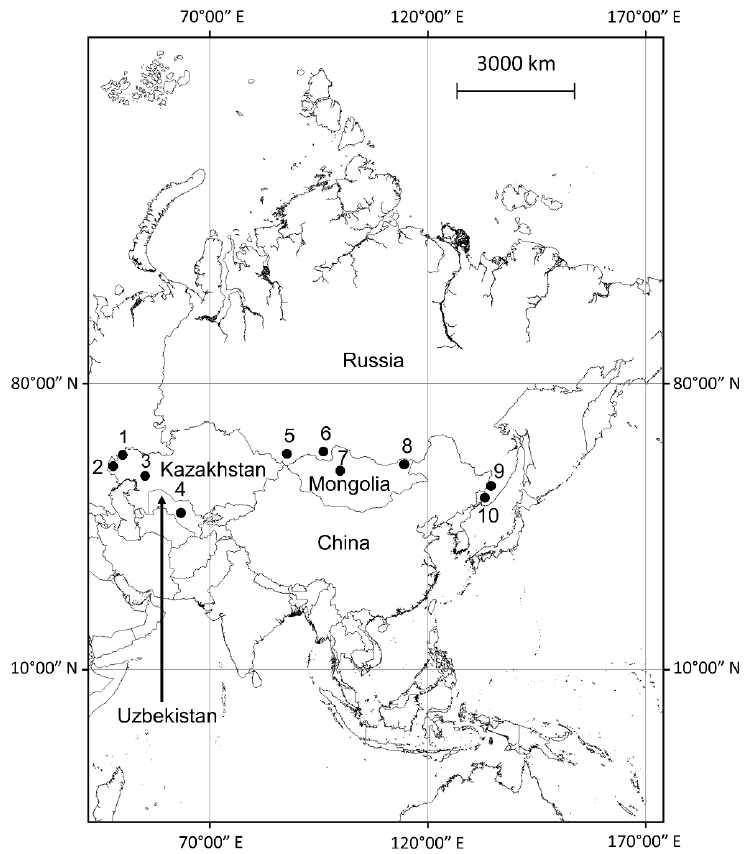
Figure 1. Field sites where Evgeniy Rotshild and his colleagues conducted investigations. Infection, animal species, region: 1—plague, the little souslik ( Spermophilus pygmaeus ), the Caspian Depres- sion; 2—plague, the tamarisk jird ( Meriones tamariscinus ) and the midday jird (M. meridianus), the Caspian Depression; 3—plague, the great gerbil ( Rhombomys opimus ), the low part of Emba River, west Kazakhstan; 4—plague, the great gerbil ( R. opimus ), the Kyzyl-Kum Desert, Uzbekistan; 5— plague, the Pallas’s pika ( Ochotona pallasi ), the Altay Mountains; southern Siberia; 6—plague, the long-tailed ground squirrel ( Urocitellus undulatus ), Tannu-Ola mountains, Tuva, southern Siberia near Mongolian border; 7—plague, the Tarbagan marmot ( Marmota sibirica ), Khangai Mountains, Mongolia; 8—pasteurellosis, Mongolian gazelle ( Procapra gutturosa ), western Mongolia; 9—tick- borne encephalitis, small rodents of the genera Apodemus and Myodes , far-eastern Russia; 10—han- taviruses, small rodents of the genera Apodemus and Myodes , far-eastern Russia. 2. Survival of Plague between Epidemics and Epizootics The terms epidemic and epizootic can have varied definitions and are often used synonymously. However, epidemic is used more often to refer to severe disease outbreaks in humans, with epizootic referring to similar phenomena in non-human animals. For the purposes of this paper, we consider the primary outcome of a plague epizootic (or epi- demic) to be the widespread mortality of the host species within a relatively short time period. After centuries of speculation about potential sources for epidemics of plague in humans, Alexander Yersin not only identified the pathogen Y. pestis ( Pasteurella pestis at that time), but also provided evidence that this pathogen is likely carried by rats [3]. Zab- olotnyi demonstrated that non-commensal free-ranging rodents, specifically marmots,